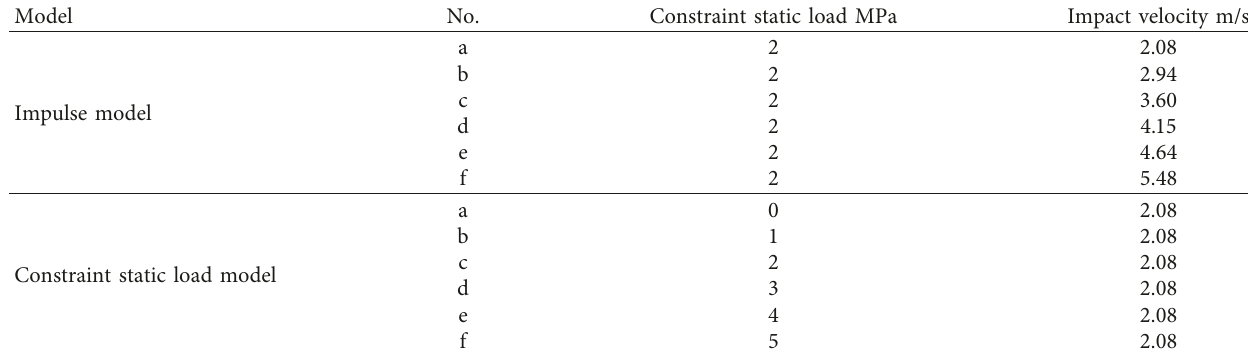
Figure 2: Schematic diagram of simulated impact loading. Table 1: Model loading mechanics parameters.